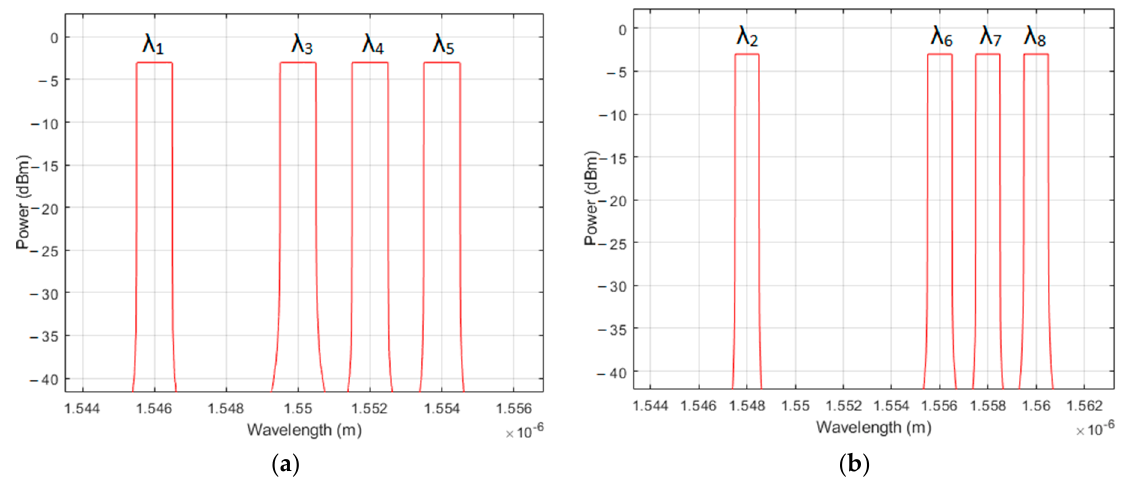
Figure 4. Encoded spectra after polarization splitting when bit “1” was transmitted: ( a ) vertical polarization at upper side; ( b ) horizontal polarization at the lower side.